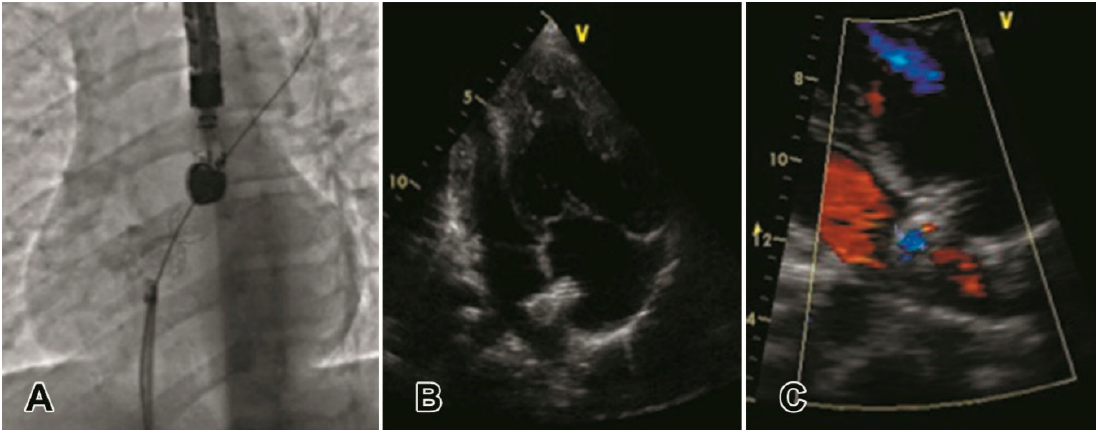
Figure 3. Examination after AS with stenting. ( A —fluoroscopy immediately after stenting; B , C — transthoracic echocardiography at follow-up). Stent is located correctly. Right heart chambers are enlarged; right-to-left shunt across the atrial septum is visualized.